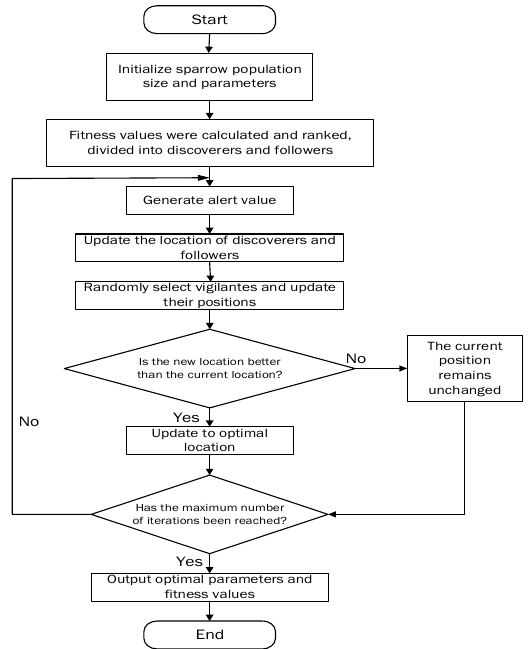
Figure 8. Flow chart of sparrow search algorithm.